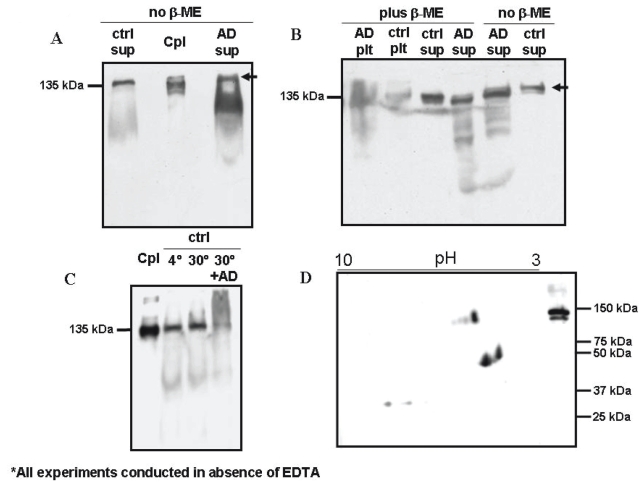
Brain ceruloplasmin shows proteolysis products in AD sample. A. Monodimensional SDS-PAGE performed in the absence of β-mercapto-ethanol shows a higher amount of the 115 kDa isoform in the AD sample. A ≅ 200kDa band is indicated by the arrow; B. Same as Panel A in the presence of β-mercapto-ethanol shows disappearance of the ≅ 200 kDa band, lower molecular weight fragments in the AD sample and presence of ceruloplasmin in cytosol and membrane fractions; C. Control sample shows a sharp band at the expected MW, even after 3 hours incubation at 30°C, whereas a smear at higher molecular weight appears when it is incubated in presence of 1/10 of the AD sample; D. 2D map of a brain extract from AD patients shows few spots at the full-length MW and some intense spots at lower molecular weight (<50 kDa). Cpl, ceruloplasmin; ctrl, control; AD, Alzheimer disease; plt, membrane fraction; sup, cytosol fraction.